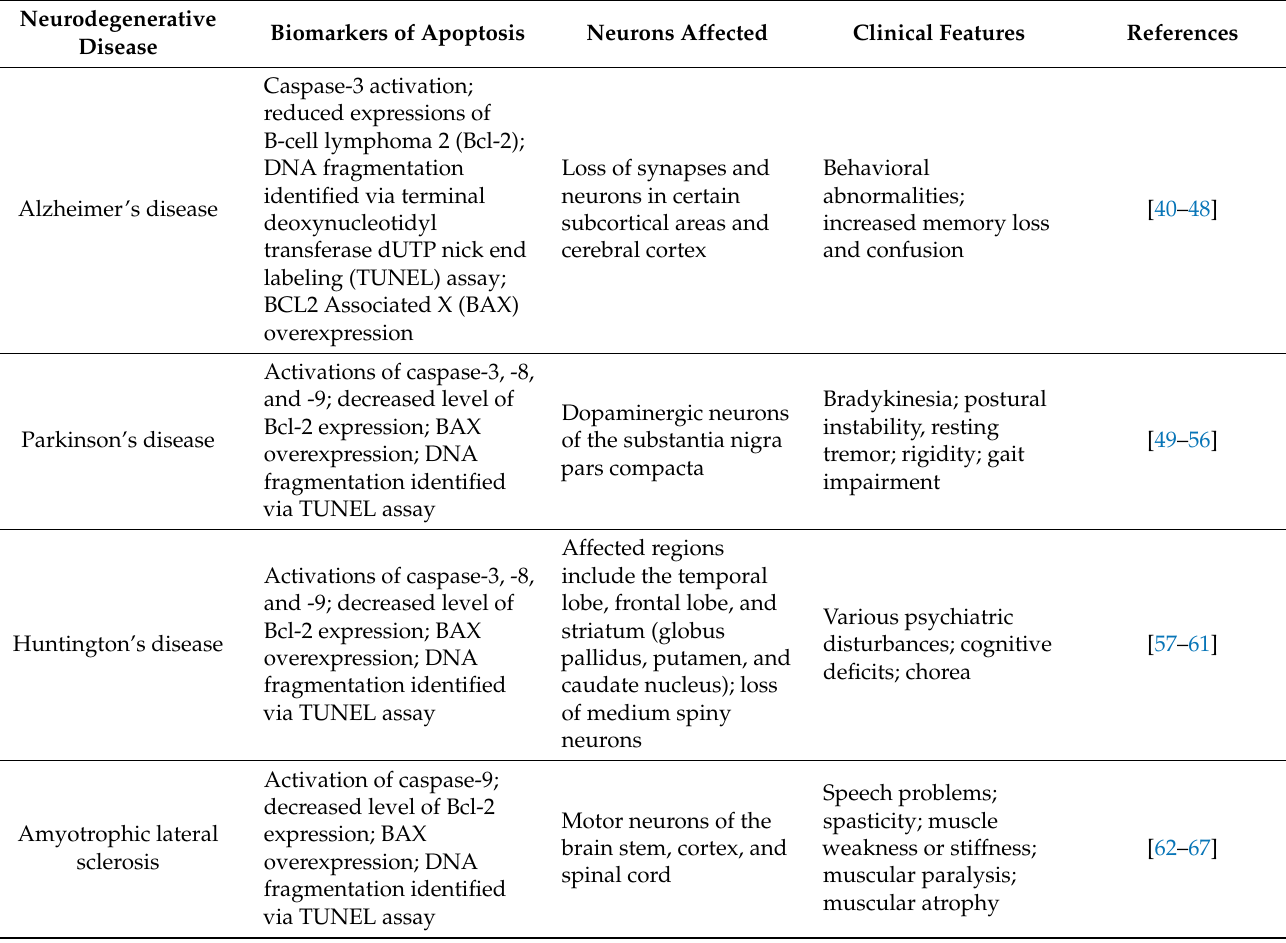
Table 1. A summary of biomarkers of apoptosis for neurodegenerative